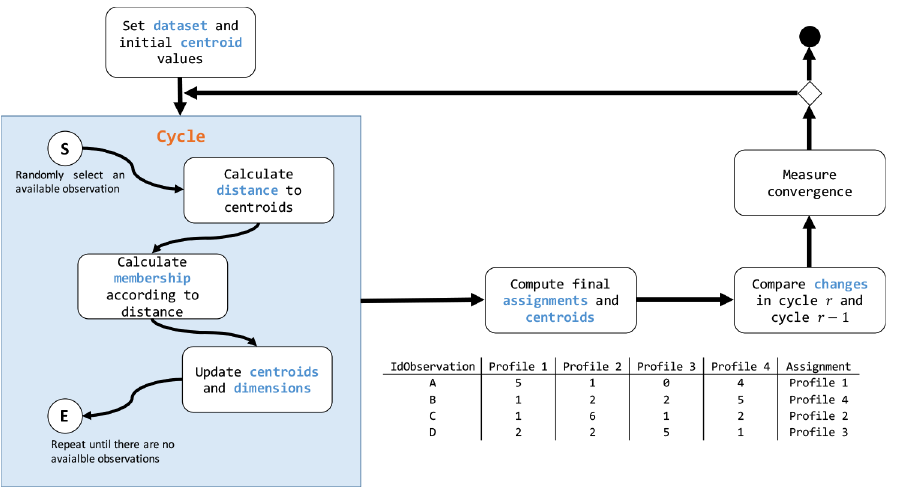
Figure 4. Clustering scheme of the semisupervised k -means